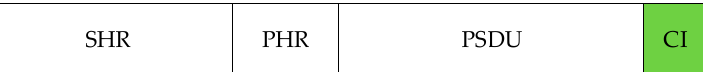
Figure 5. Classification of congestion conditions. 3.3. Congestion Control Congestion control is classified into the following four categories: (1) Traffic control [28]: in this technique, congestion is mitigated by means of reducing the number of packets injected into ad-hoc networks. (2) Resource control [24]: in this case, congestion is handled by, for example, increasing network resources or using other idle or uncongested paths for the transmission of data towards the sink. (3) Priority-aware congestion control scheme [9]: in this scheme, congestion is managed by considering different priorities in congestion situations. (4) Queue-assisted technique [23]: congestion is tackled by the queue length of the nodes. Our proposed congestion control method (HBCC) combines (1), (3) and (4). In HBCC, the queue length of nodes is used as the symbol of congestion control, and then the queue length of nodes is reduced as much as possible by using the method of traffic control. HBCC includes two traffic control methods: HRCC and HSCC. If the effect of traffic control is not good, the priority-aware congestion control scheme is used. The priority-aware congestion control scheme in HBCC is HPCC. The congestion control of HBCC is shown in Figure 6.